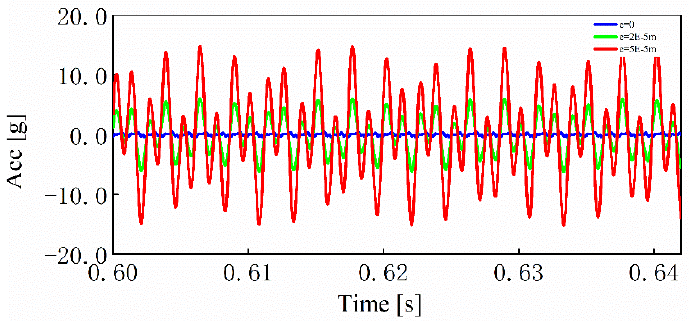
Figure 18. Time domain diagram of vibration acceleration under different transmission errors.